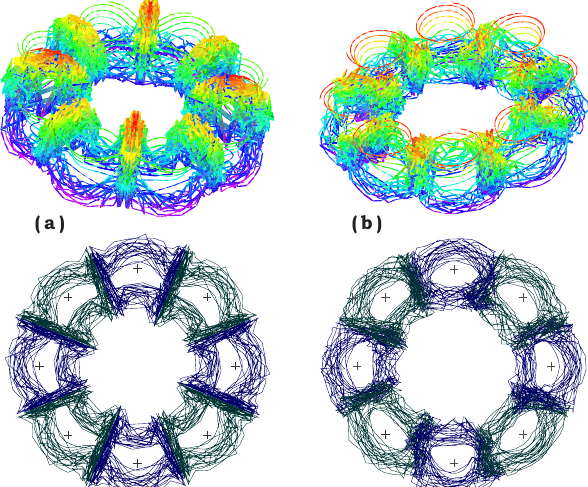
Figure 18. Octocopter’s free-wake examples: ( a ) all propellers are in-phase; ( b ) propellers are out-of-phase.